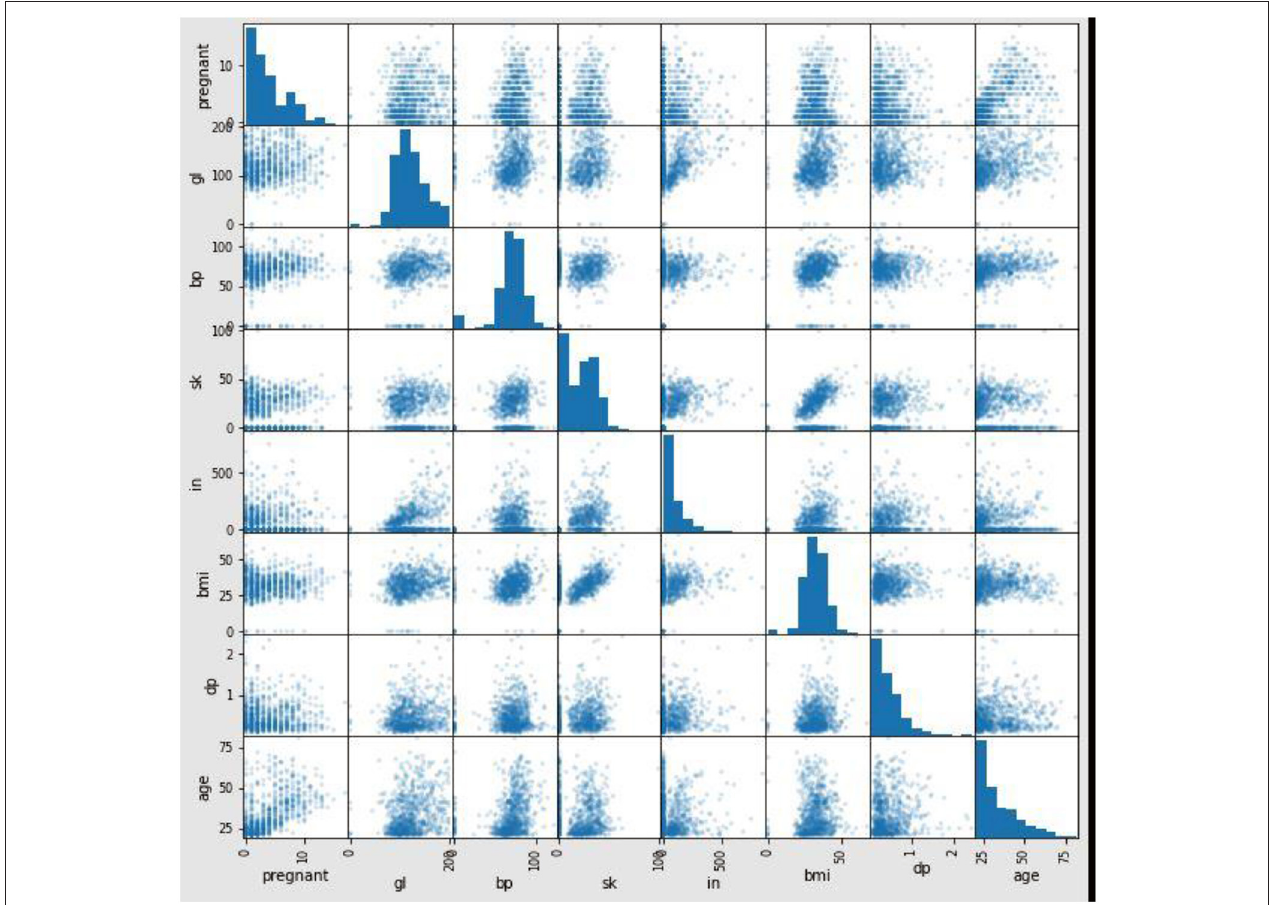
FIGURE 6 | Pearson correlation coefficient of Pima dataset input attributes.